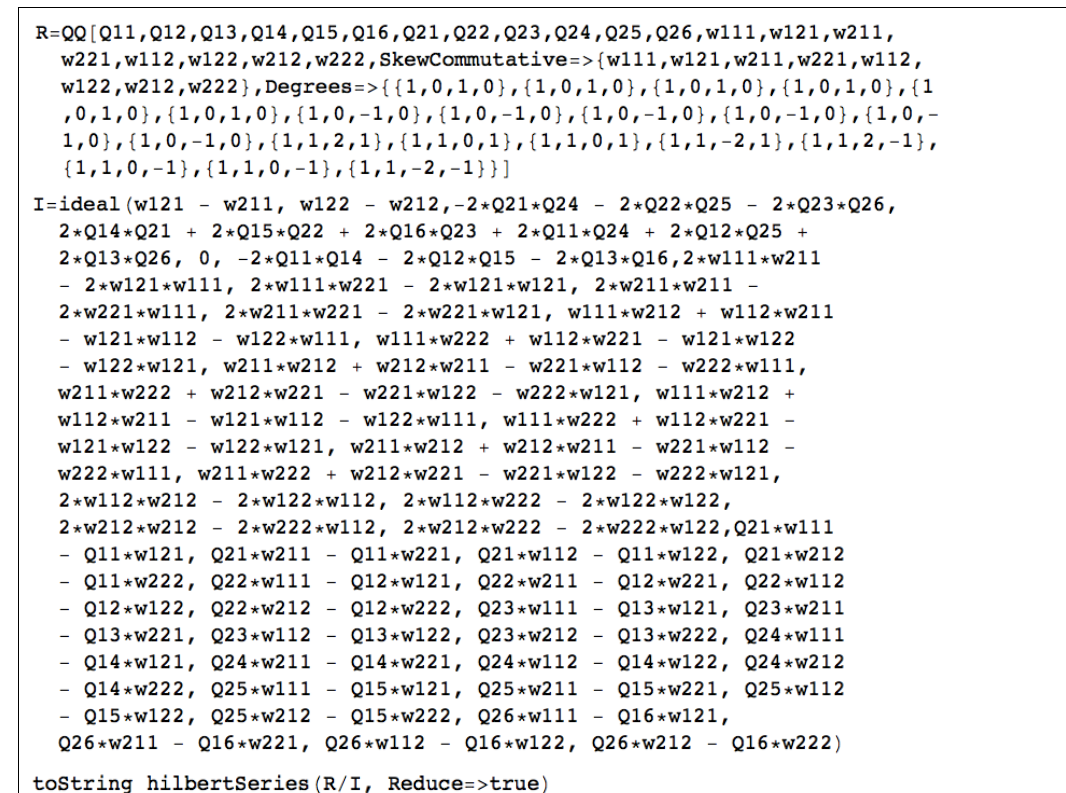
Figure 1 . A Macaulay2 code to compute the Hilbert series of the ring of variables Q i N f = 3, subject to the conditions (A.1), (A.2), (A.3), (A.4) and (A.5). Here we write Q i and ( W (cid:11) ) ab as wab (cid:11) . The ring R is multi-graded with respect to the following charges (in order): 1. the R -charge associated with the fugacity t , 2. the number of gaugino super(cid:12)elds associated with the fugacity w , 3. the weights of the SU(2) gauge group, and 4. the weights of the SU(2) symmetry associated with the index (cid:11)